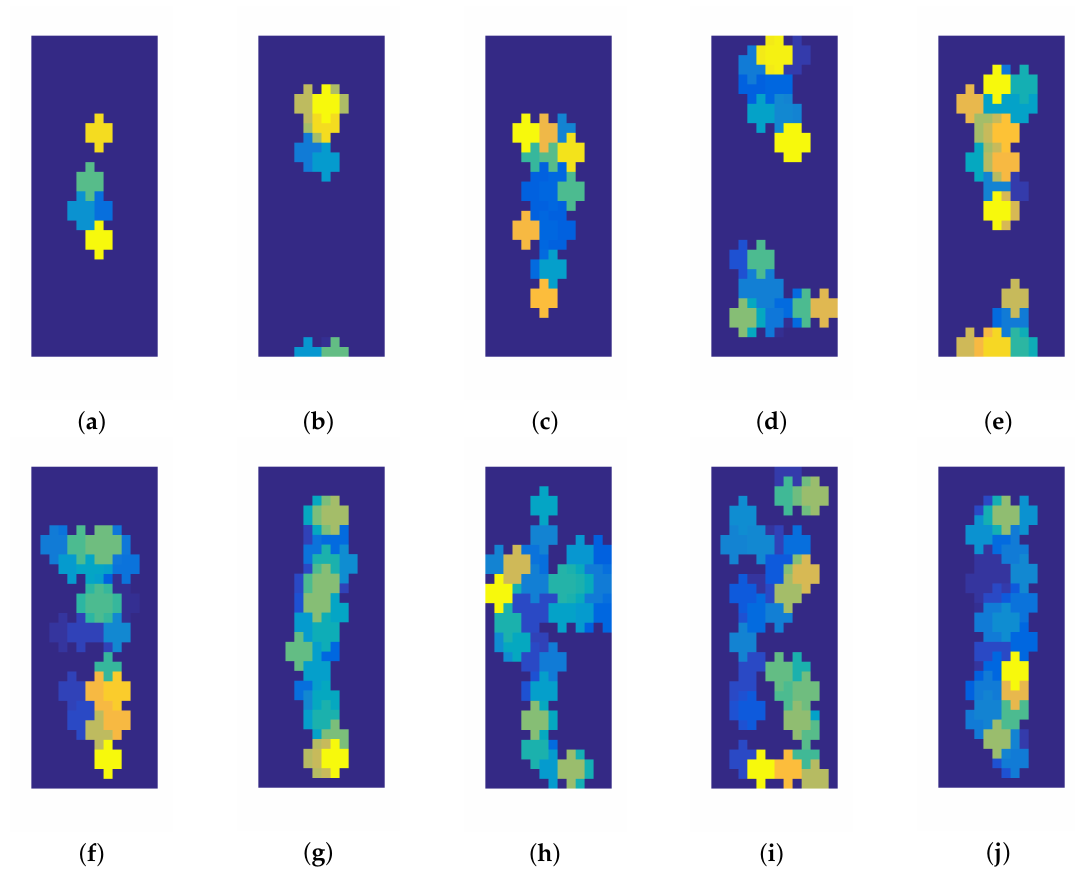
Figure 6. Projection image with different number of point clouds. Numbers in parentheses indicate cosine similarities. ( a ) Five points (0.36); ( b ) 10 points (0.38); ( c ) 15 points (0.46); ( d ) 22 points (0.49); ( e ) 26 points (0.53); ( f ) 30 points (0.54); ( g ) 35 points (0.58); ( h ) 40 points (0.59); ( i ) 43 points (0.61); ( j ) 49 points